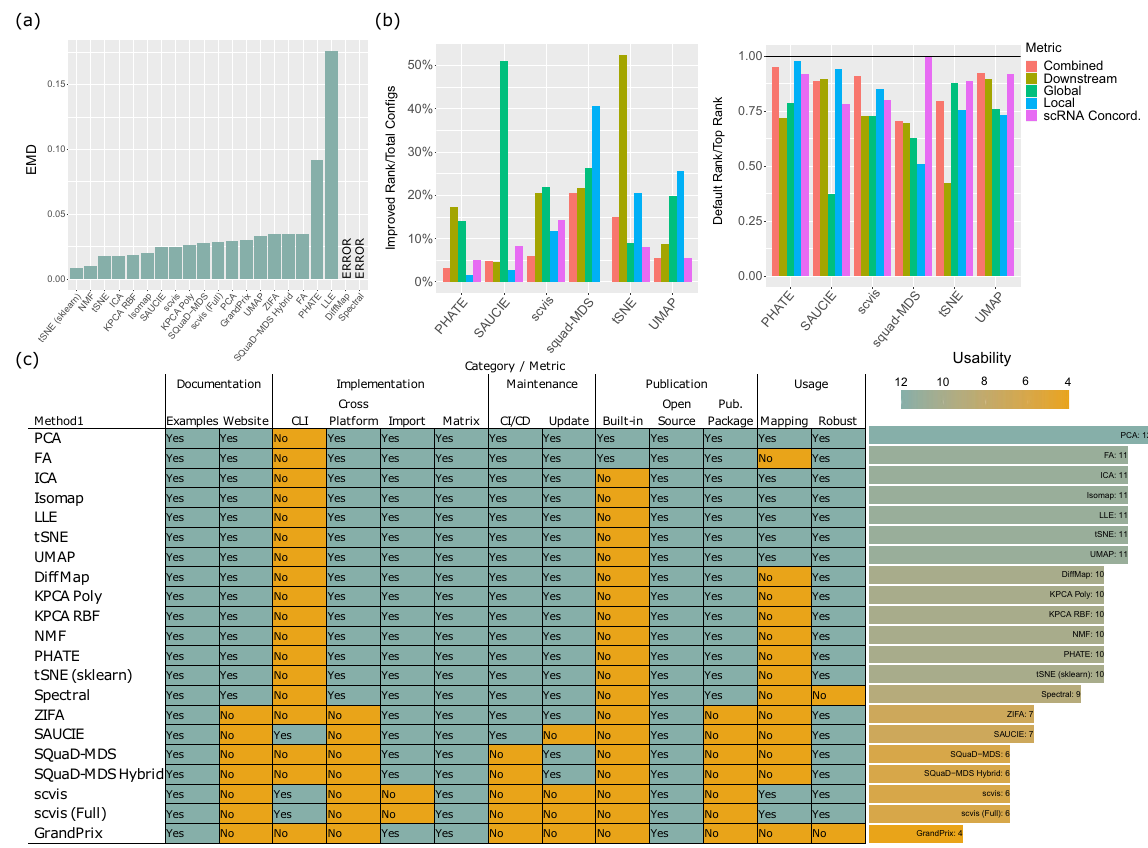
Fig. 6 | Detailed results on the stability and usability performances of the DR methods. a The stability of the DR methods. We calculated the stability of the DR methods, across different bootstrap datasets generated from the Oetjen cohort ’ s SampleA. b TheimpactofparametertuningontheaccuracyoftheDRmethods,in comparison with the default settings. In the left panel, we showed the optimal settings ’ (amongalltestedsettings,SupplementaryData4)increasesinranks(over default settings ’ ranks) divided by the total number of con fi gurations for each method and each category. The right panel shows the relative performance of the